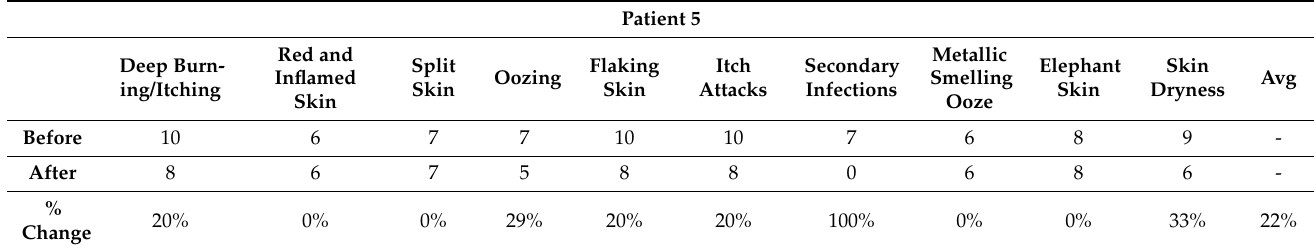
Table 7. Severity scores for Patient 5 before and after completing the study. The numbers in the table are out of ten, with ten being the worst severity, and zero meaning the symptom has ceased to exist. The percentage change in the severity of each symptom is shown in the bottom